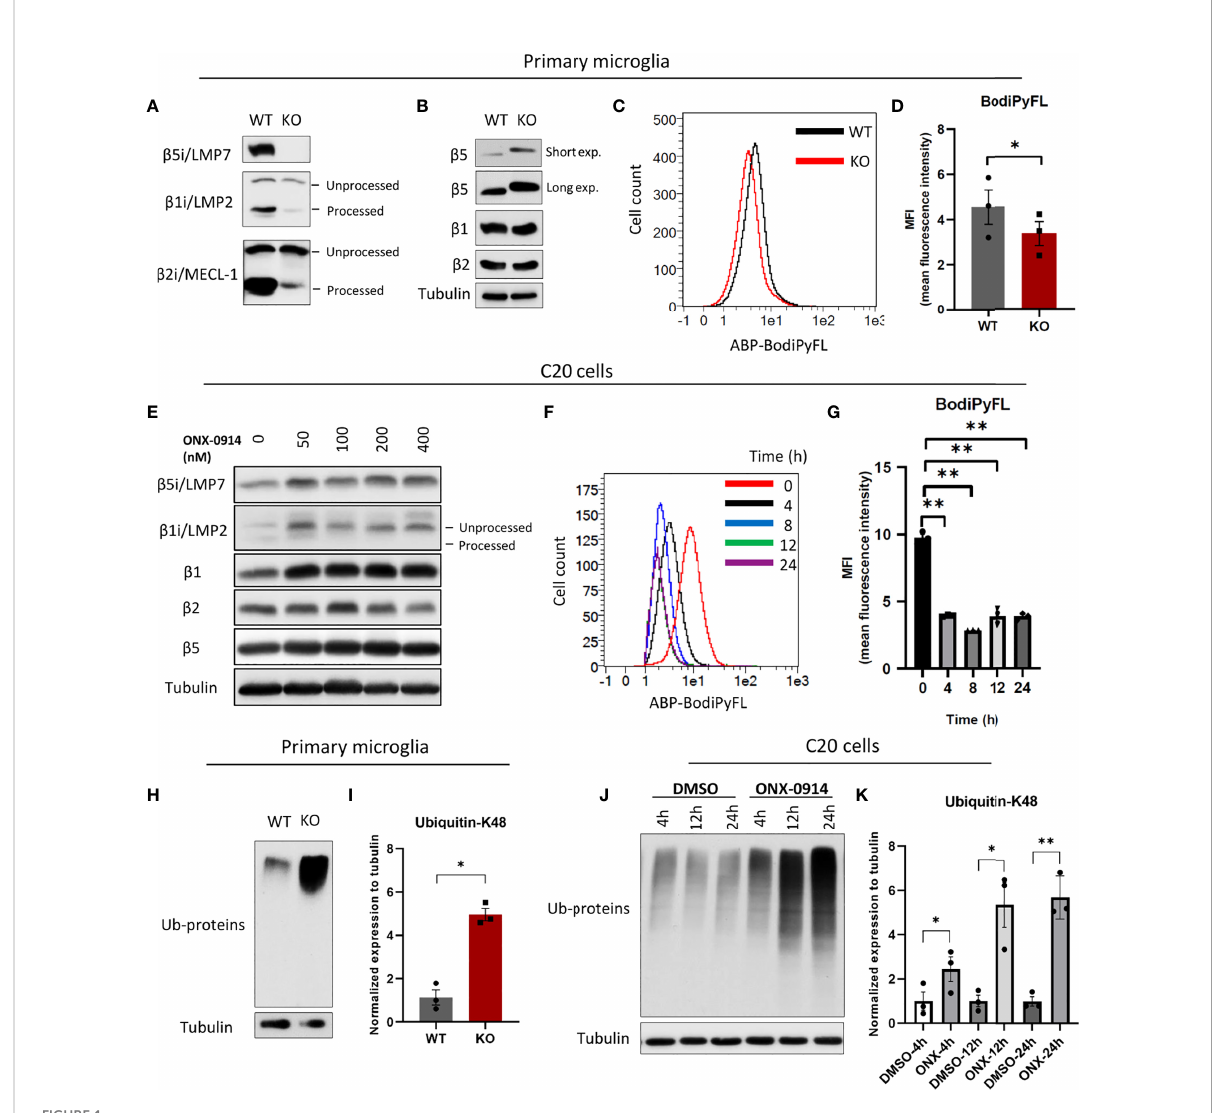
FIGURE 1 Immunoproteasome impairment disturbs protein homeostasis in microglia. (A) Western blot analysis of immunoproteasome catalytic subunits in WT and b 5i/LMP7 KO primary microglia. (B) Western blot analysis of standard proteasome catalytic subunits in WT and b 5i/LMP7 KO primary microglia. (C) Primary murine microglia were incubated with 500nM of pan-reactive proteasome activity-based probe Me4BodiPyFL-Ahx3Leu3VS (ABP) for 2 hours to stain proteasome active sites, histograms showing FITC-ABP signals in WT (black) and KO (red) microglia. (D) Bar graph showing the comparison of proteasome active sites in WT and b 5i/LMP7 KO primary microglia as indicated by MFI (mean fl uorescence intensity) of FITC-ABP Me4BodiPyFL-Ahx3Leu3VS. (E) Western blot analysis of proteasome catalytic subunits in human microglia C20 cells treated with different doses of ONX-0914 for 24h. (F) Histograms showing FITC-ABP signals in C20 cells untreated (red) or treated with 200nM ONX-0914 for 4h (black), 8h (blue), 12h (green) and 24h (purple). (G) Bar graph showing the comparison of proteasome active sites in C20 cells untreated or treated with 200nM ONX-0914 for indicated time (MFI (mean fl uorescence intensity) of FITC-ABP Me4BodiPyFL-Ahx3Leu3VS). (H) Western blot analysis of poly-ubiquitylated proteins in WT and b 5i/LMP7 KO primary microglia. (I) Quanti fi cation of Western blot data from fi gure 1H. (J) Western blot analysis of poly-ubiquitylated proteins in C20 cells treated with 200nM ONX-0914 or DMSO for indicated time. (K) Quanti fi cation of Western blot data from fi gure 1J. All data are given (n=3) by mean ± SEM; *: P < 0.05, **: P <